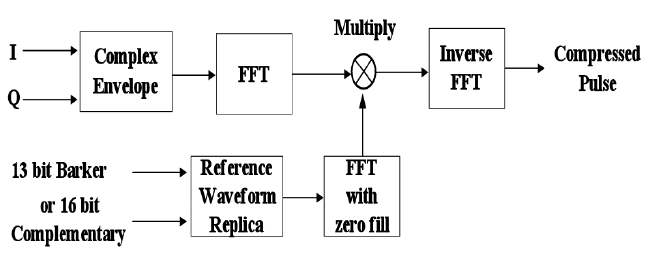
Figure 6. Block diagram of the digital pulse compression.